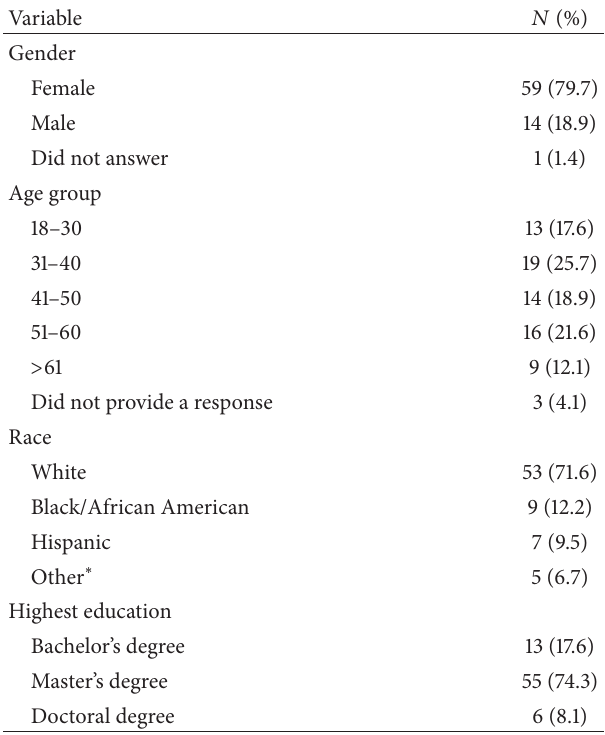
Table 1: Demographic information ( 𝑁 = 74). Table 2: Employment information: credentials, years of experience, and occupation ( 𝑁 = 74